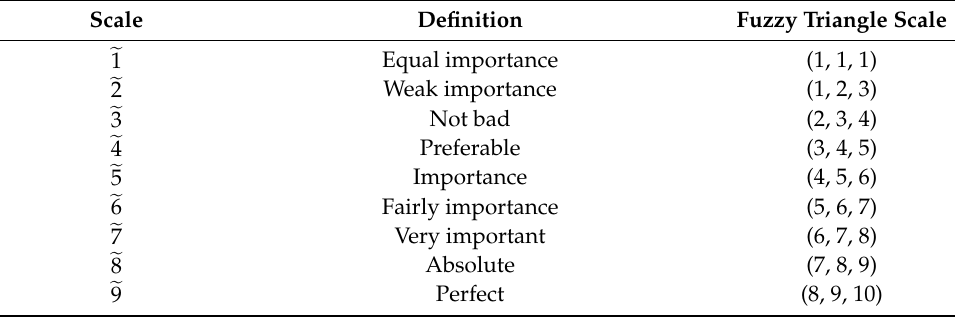
Table 3. Linguistic terms in FAHP